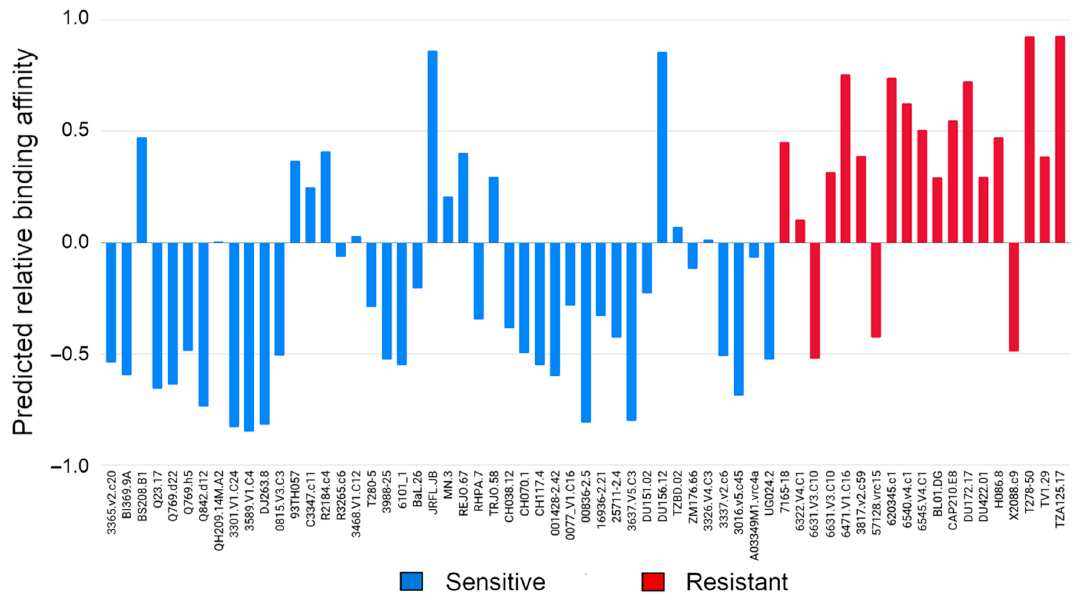
Figure 4. Predicted relative binding affinities of 45 sensitive (blue) and 19 resistant (red) HIV-1 gp120 strains towards VRC01, extracted from PELE simulations (Figure 3). Most of the sensitive strains are correctly predicted (33 out of 45), while most of the resistant strains are also predicted as such (16 out of 19).